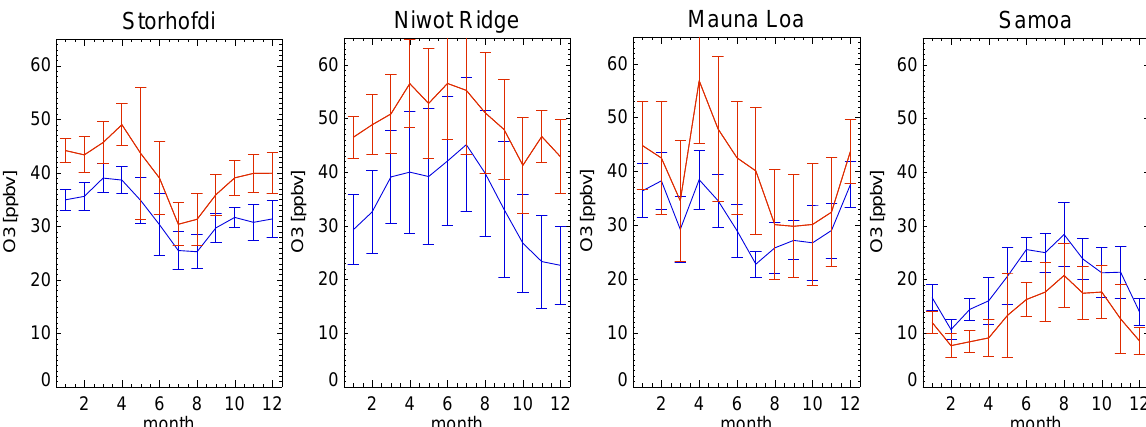
Fig. 14. The annual cycle in the simulated ozone concentrations (blue) compared to surface measurements from the GMD network (red) at the stations Storhofdi, Iceland (63.3 ◦ N, 20.3 ◦ W), Niwot Ridge (41.1 ◦ N, 124.2 ◦ W), Mauna Loa (19.5 ◦ N, 155.6 ◦ W), and Samoa (14 ◦ S, 170.5 ◦ W). Model data has been sampled at the time of the observations. The error bars indicate the standard deviation in the monthly means.